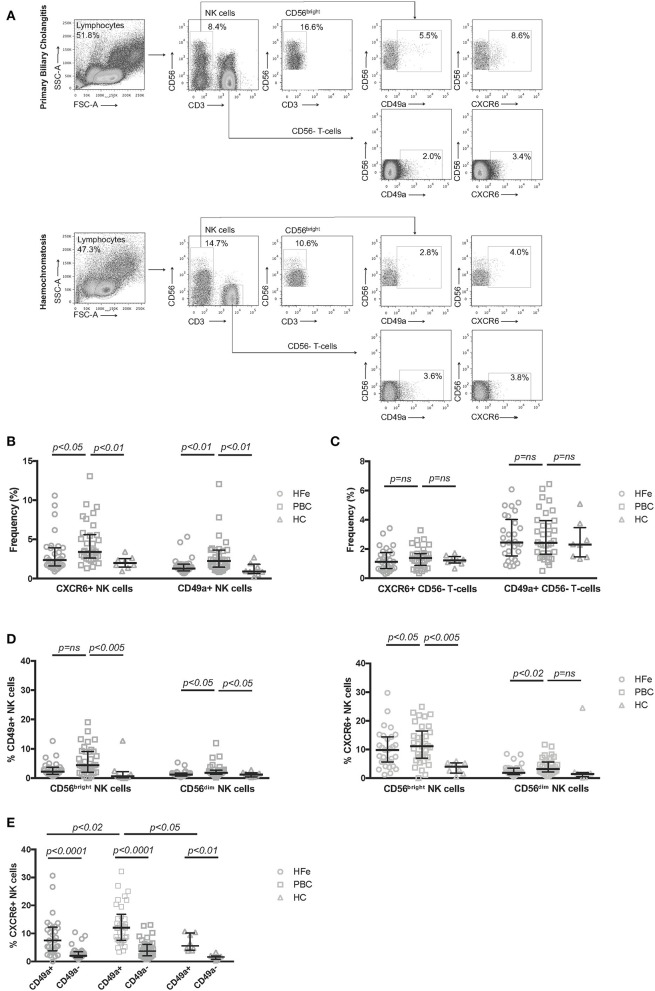
(A) Representative flow cytometry plots showing the gating strategy used to define CD56bright, CXCR6+ and CD49a+ NK cell subpopulations within PBMCs. Representative plots are shown for patients with PBC and HFe. (B) The frequency of CXCR6+ and CD49a+ NK cells within the peripheral CD3-CD56+ NK cell population for individuals with HFe (n = 31), PBC (n = 34), and HC (n = 8). (C) The frequency of CXCR6+ and CD49a+ CD56- T-cells within the CD56- T-cell population for individuals with HFe (n = 31), PBC (n = 34), and HC (n = 8). (D) The frequency of CD49a+ and CXCR6+ NK cells within the CD56bright and CD56dim NK cell populations for individuals with HFe (n = 31), PBC (n = 34), and HC (n = 8). (E) The frequency of CXCR6+ NK cells within the peripheral blood CD49a+ and CD49a- NK cell populations for individuals with HFe (n = 31), PBC (n = 34), and HC (n = 8). Dot plots show individual values, the median and interquartile range. Patient groups were compared using the Kruskal-Wallis test with Dunn's multiple comparison test. The Wilcoxon matched pairs test was used to compare CD49a+ and CD49a- populations within the same patient group.